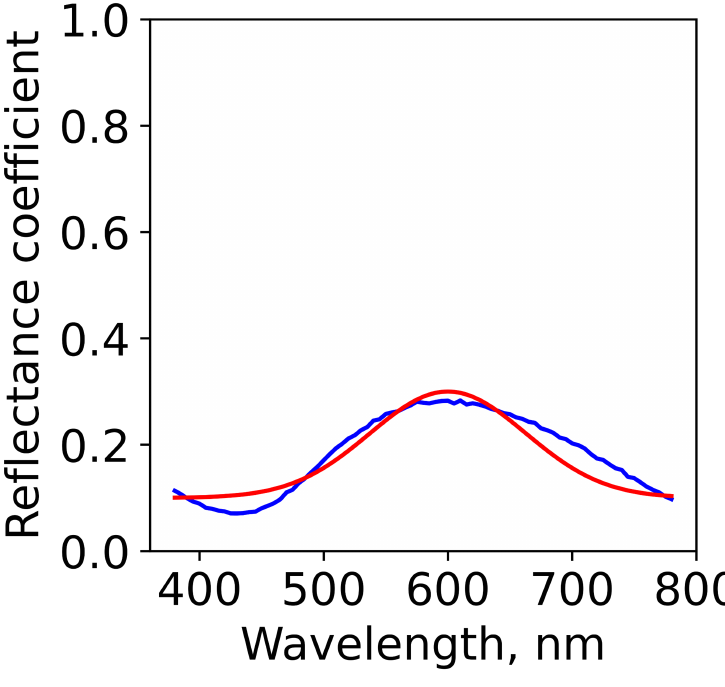
Figure 7. An example of model performance when asked to design a structure to produce an arbitrary response within the material capabilities. The predicted (blue) curve shows good similarity to the target (red) curve, with the peaks and troughs in good agreement and a percentage accuracy of 88%. The predicted material depths were [61.4 49.4 65.3 46.5 52.6 12.1]